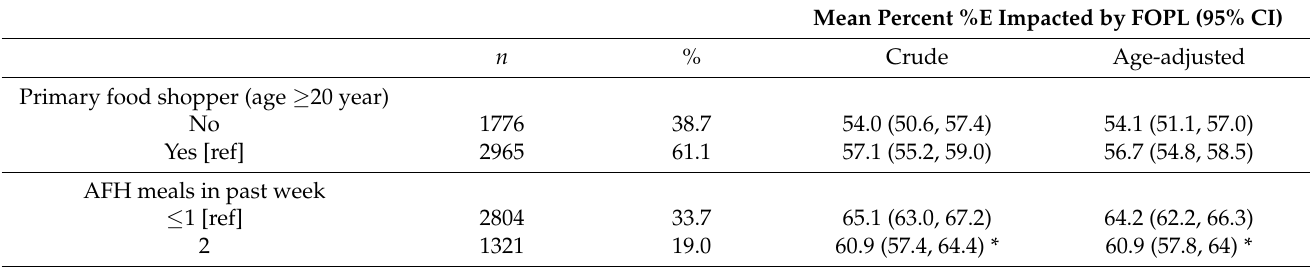
Table 2. Proportion of population’s diet in terms of daily energy impacted by FOPL in the United States by diet behaviors, diet quality and selected health behaviors,